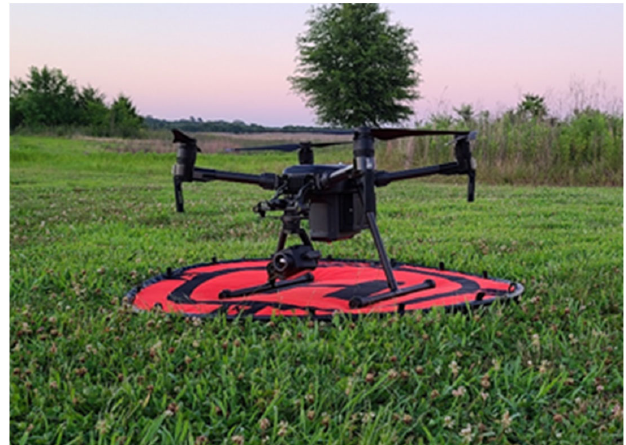
Figure 1. Small, unmanned aircraft system used in this study—Quadcopter—DJI Matrice 200 V2— equipped with visible/thermal sensor payload—Zenmuse XT2—that was used to capture imagery.